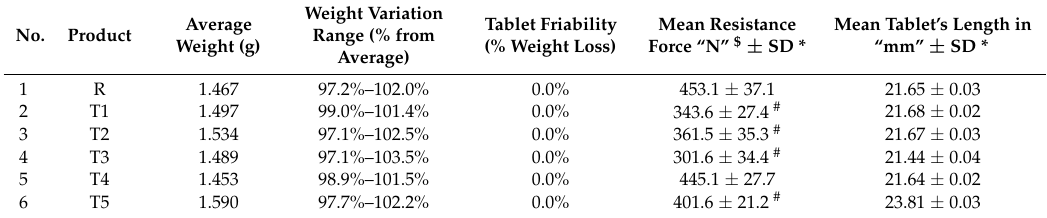
Table 2. Physical attributes of tested amoxicillin trihydrate/potassium clavulanate tablets (1 G) from different